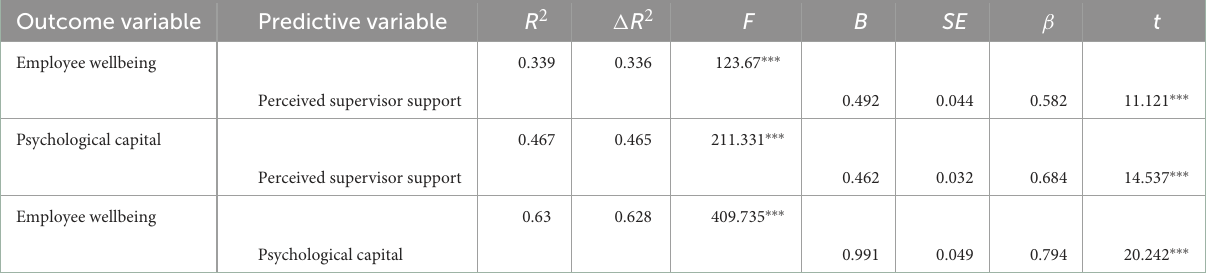
TABLE 2B Regression